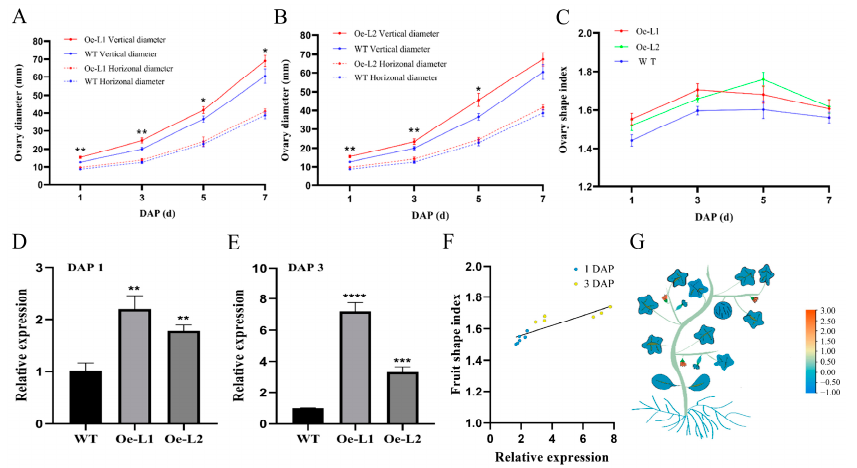
Figure 7. Statistical data of CmSUN25-26-27c -overexpressed transgenic fruits. ( A , B ) Vertical and horizonal diameter comparison of the fruits at 1 DAP (day after pollination), 3 DAP, 5 DAP, and 7 DAP in transgenic lines and WT. ( C ) Statistical analyses of ovary shape index in transgenic lines and WT in DAP 1~7. ( D , E ) qRT-PCR analyses of CmSUN25-26-27c expression in the ovary at 1 DAP and 3 DAP. Oe-L1 and Oe-L2 indicate CmSUN25-26-27c -overexpressed transgenic lines. ( F ) Scatter- plot analysis shows the relevant of FSI and CmSUN25-26-27c expression. ( G ) Schematic model of relative expression of CmSUN25-26-27c in different melon tissues. * p value < 0.05; ** p value < 0.01; *** p value < 0.001; **** p value <